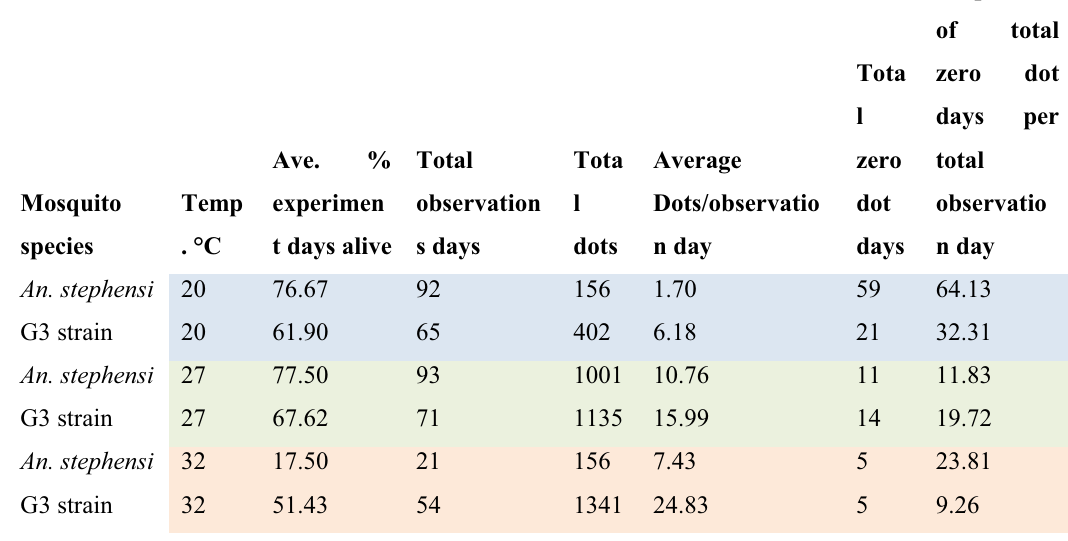
Table 3. Summary of sugar feeding results comparing two species at three temperatures. The shaded values provided in Table 3 are important because each color represents a given temperature. The blue color refers to the results of thepresence of dotes for mosquitoes (both species) kept at 20°C. The green color is the results for mosquitoes kept at 27°C and the orange color is formosquitoes kept at